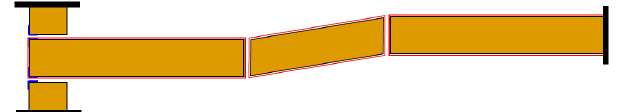
Figure 10. How to hide the CAM ribbons to meet the aesthetic requirements: a ) arrangement in slit of a steel ribbon and its protective steel plates; b ) restoring of the cover stone material.